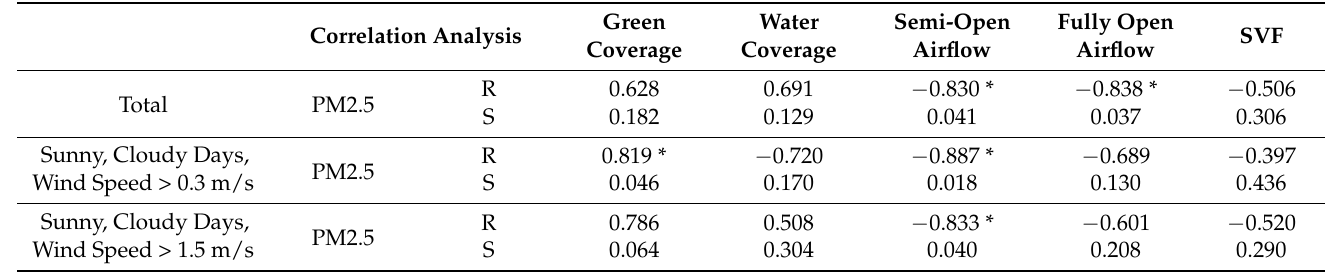
Table 4. Correlation of PM2.5 concentration and greenspace elements.